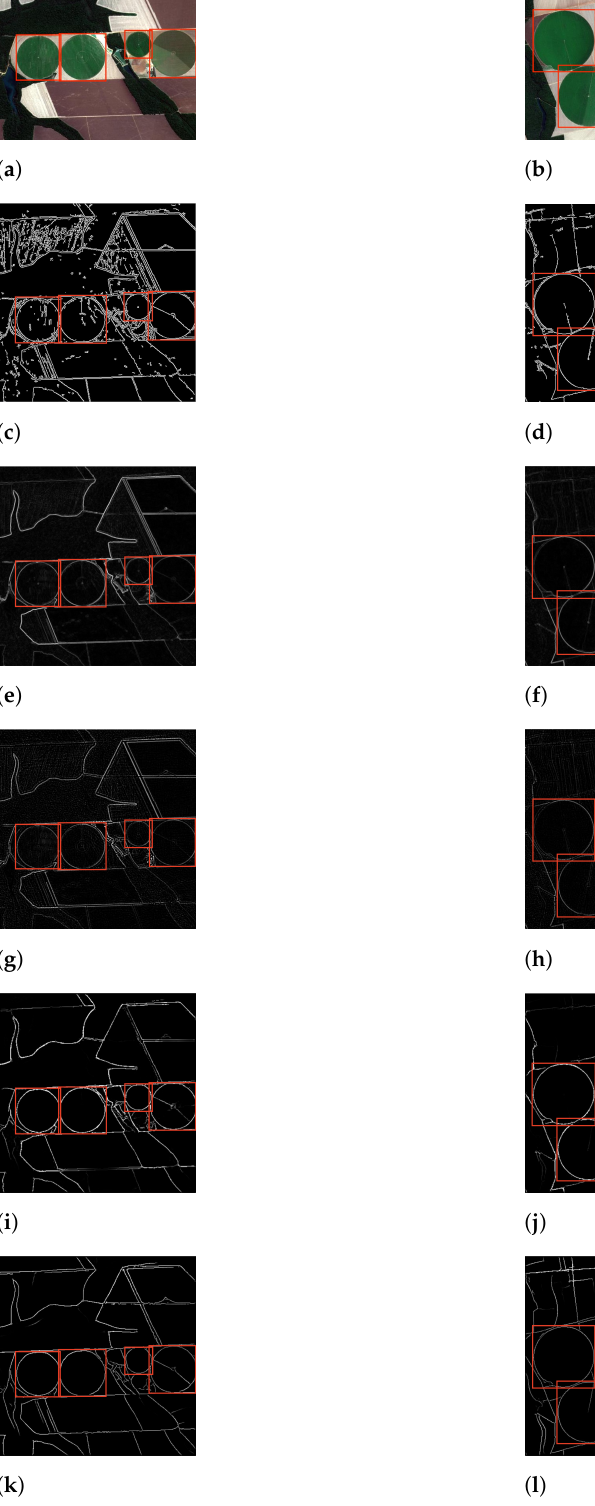
Figure 2. Examples of the samples. ( a , b ) Ordinary samples. ( c , d ) Edge image samples extracted using Canny edge detector. ( e , f ) Edge image samples extracted using Sobel edge detector. ( g , h ) Edge image samples extracted using Laplacian edge detector. ( i , j ) Edge image samples extracted using HED. ( k , l ) Edge image samples extracted using